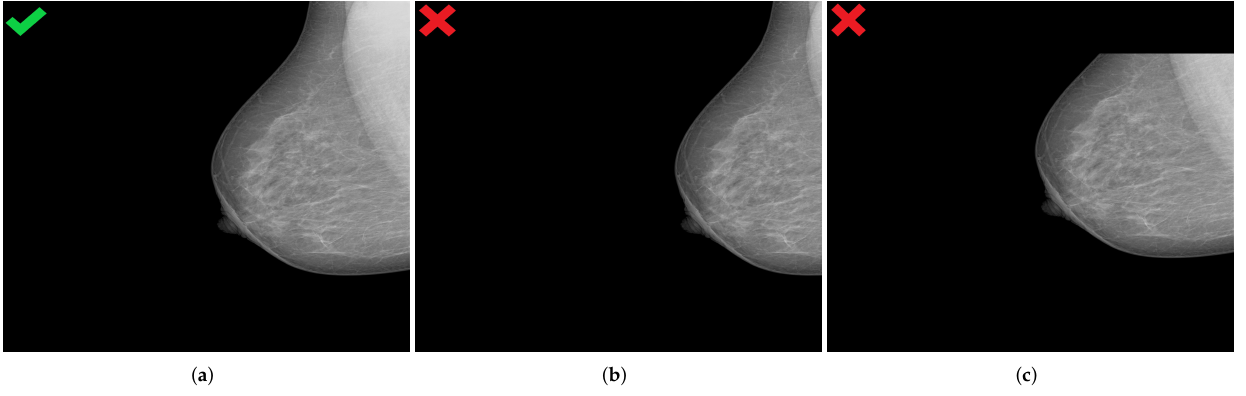
Figure 12. Generated mammograms with poor positioning quality by applying appropriate hori- zontal shift ( b ) and vertical shift ( c ) from an originally well-positioned mammogram ( a ). ( a ) Well- positioned mammogram (MLO view); ( b ) pectoralis muscle showing improper height and angle; ( c ) missing breast area in upper